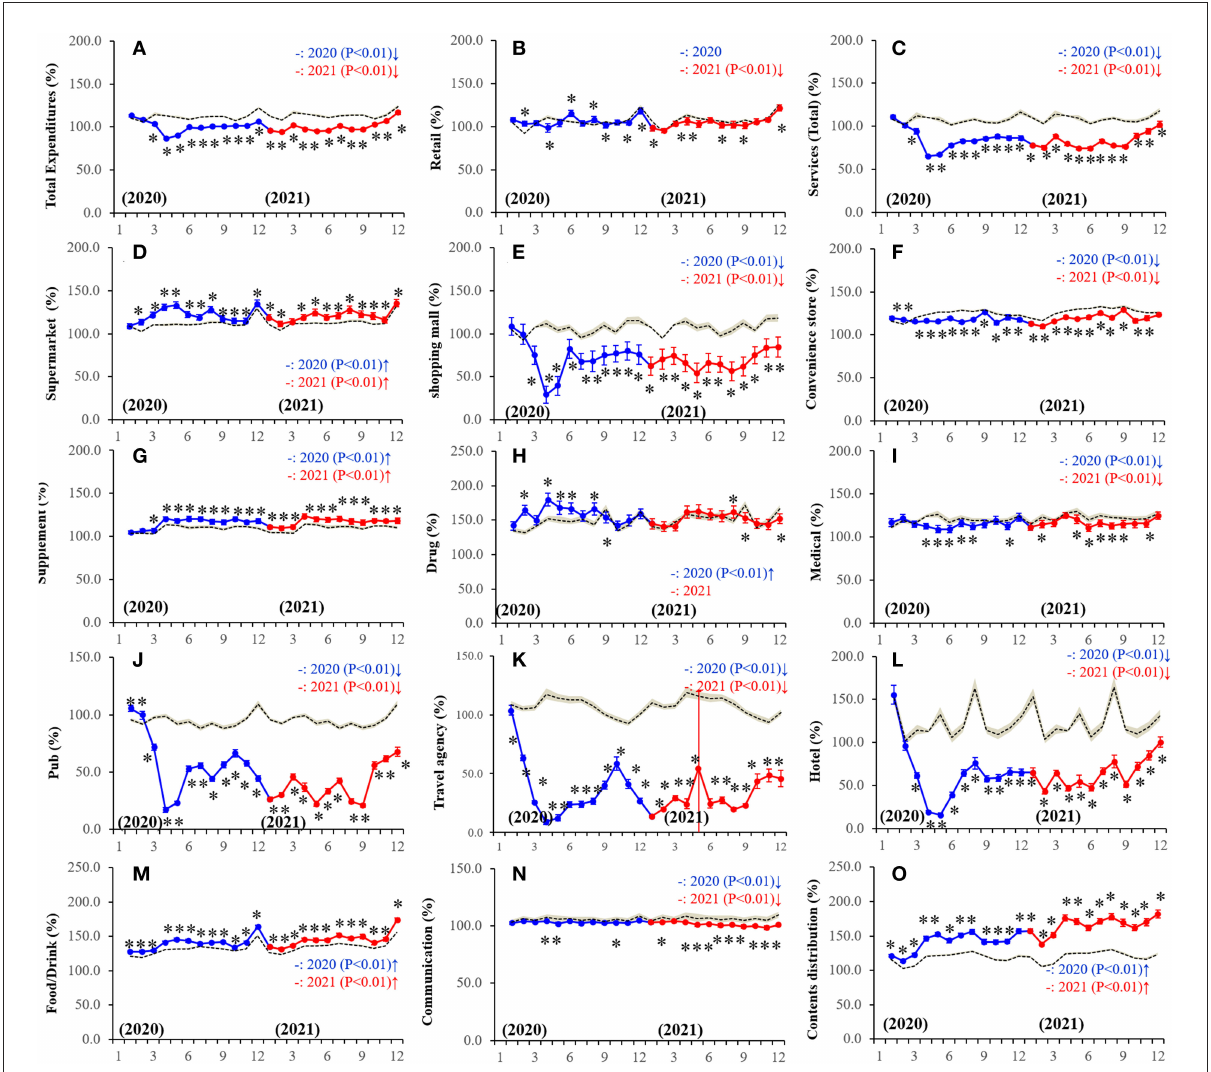
FIGURE3 Fluctuations of monthly expenditures during the COVID-19 pandemic in Japan. (A) total expenditure, (B) retail, (C) service (total), (D) supermarket, (E) shopping mall, (F) convenience store, (G) supplement, (H) drug (nonprescription drug), (I) medical, (J) pub, (K) travel agency, (L) hotel, (M) food/drink, (N) communication, and (O) contents distribution. Ordinates indicate the relative personal expenditures between January 2020 and December 2021 per that in March 2016 (%), and abscissas indicate the month. Dotted, blue, and red lines indicate the average predicted and observed personal expenditures in 2020 and 2021, respectively. Brown areas, blue and red bars indicate the 95% CI for predicted and observed personal expenditures in 2020 and 2021, respectively. * p < 0.05, significant change of monthly personal consumption expenditures in comparison to predicted vales using a linear mixed-effects model with Scheffe’s post-hoc test. ↑ and ↓ indicate significantly higher and lower observed monthly expenditures in comparison to predicted monthly expenditures,